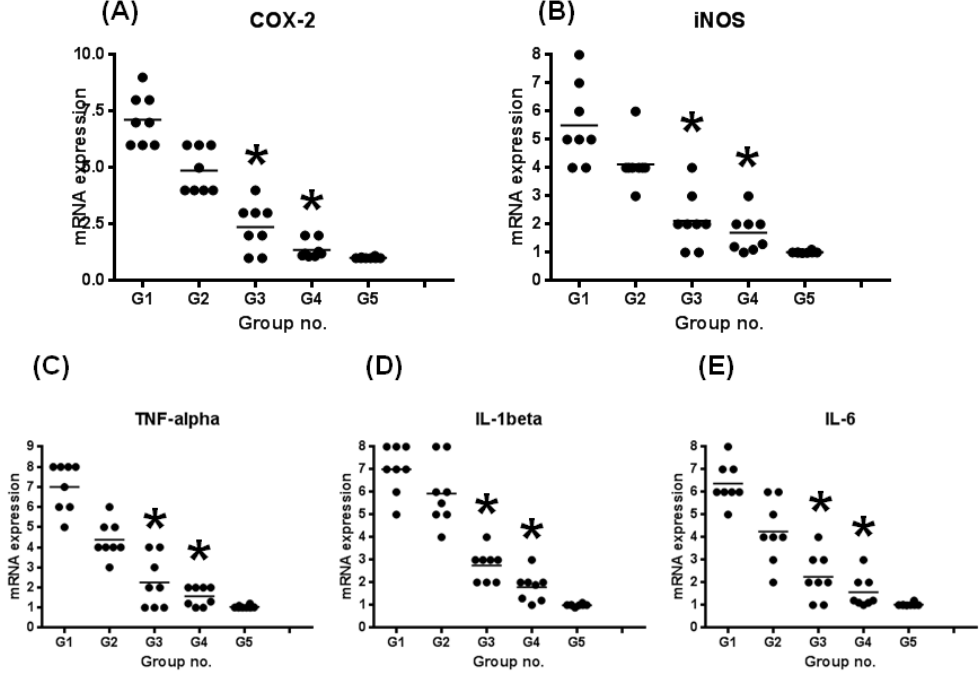
Figure 4. The mRNA expression levels of inducible inflammation-related enzymes and pro-inflammatory cytokines in colorectal tissue samples from mice treated with DSS with or without Hrh antagonists. Total RNA was extracted from the colorectal tissues of untreated and DSS/antagonists-treated mice. The mRNA levels of ( A ) COX-2, ( B ) iNOS, ( C ) TNF- , ( D ) IL-1 and ( E ) IL-6 were measured by quantitative RT-PCR. Treatment with cimetidine or clobenpropit in the diet significantly decreased the mRNA expression of all molecules ( * p < 0.05). The expression was normalized to the -actin mRNA expression level. The data are expressed as the means SD from three independent assays (n=8 from each group). The ordinates show the relative mRNA expression (/ -actin).